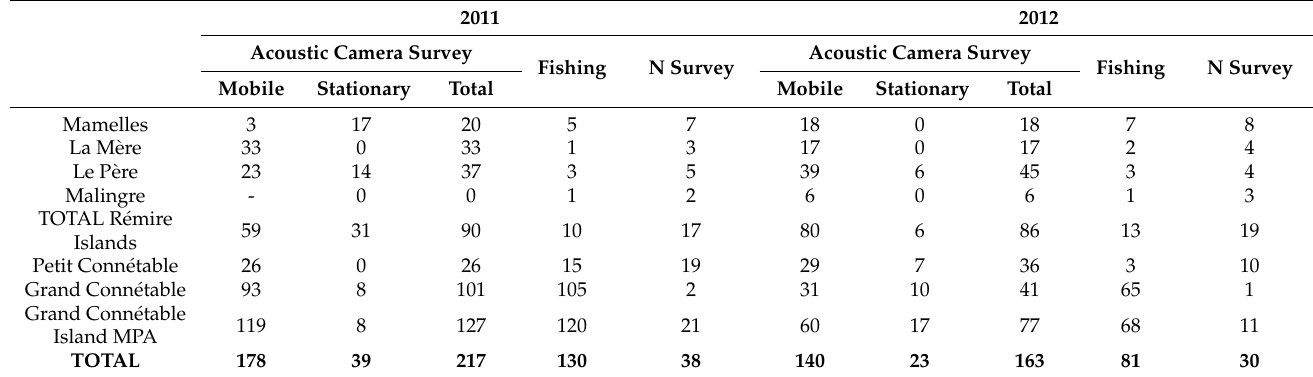
Table 2. Number of goliath groupers counted around rocky sites using the acoustic camera and fishing in 2011 and 2012. N survey: number of fishing trips.